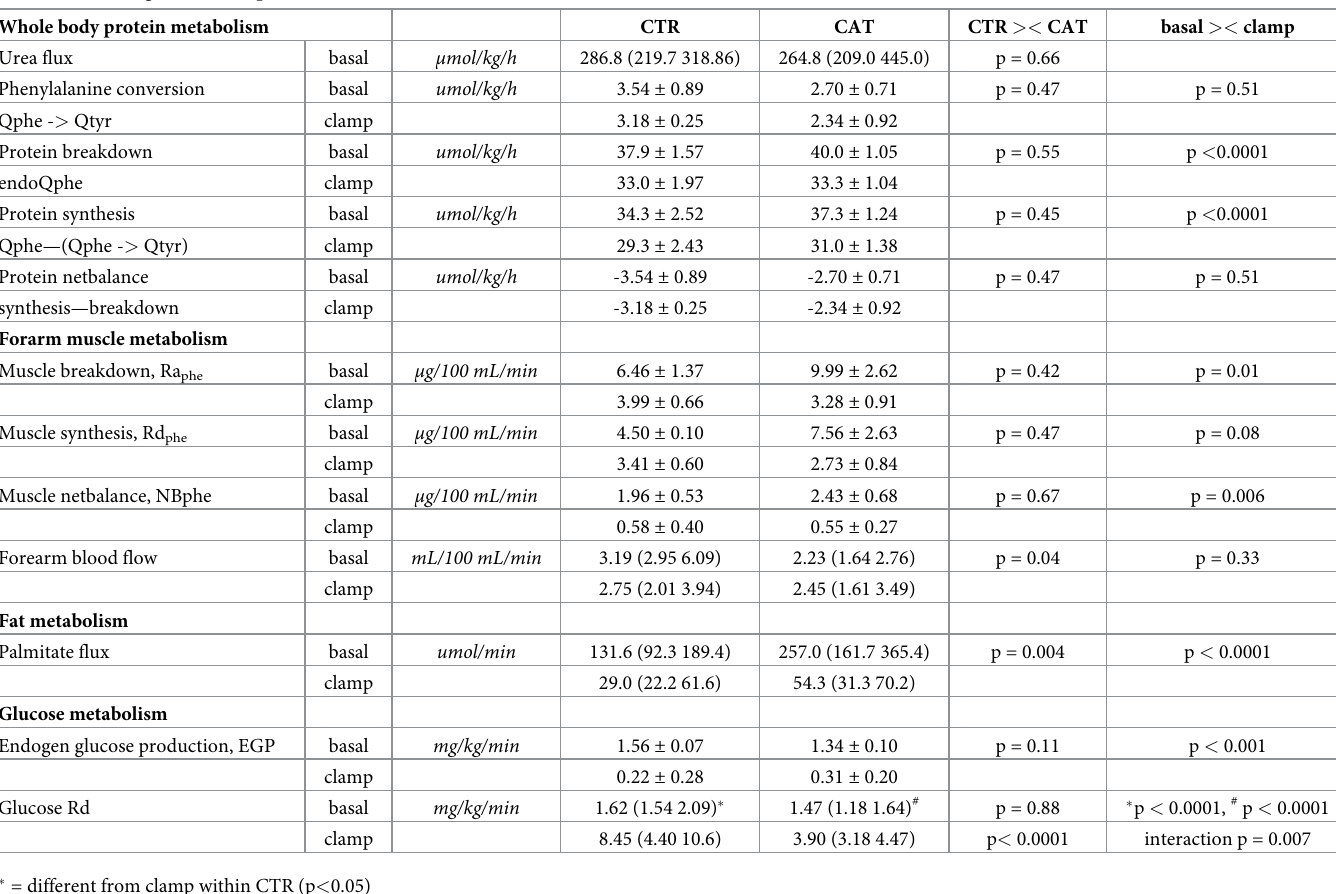
Table 3. Protein, glucose and lipid